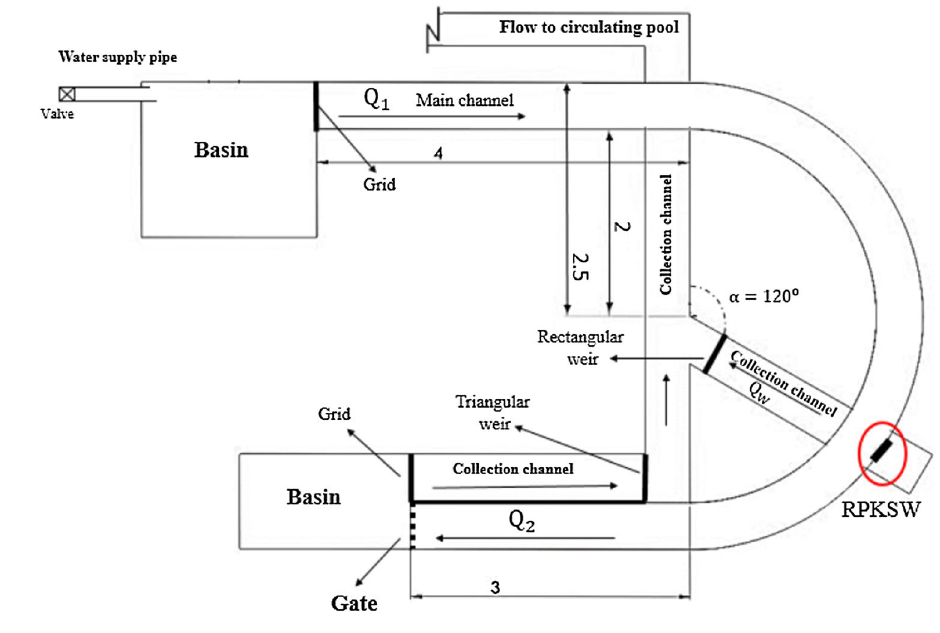
Fig. 2 A schematic view of the